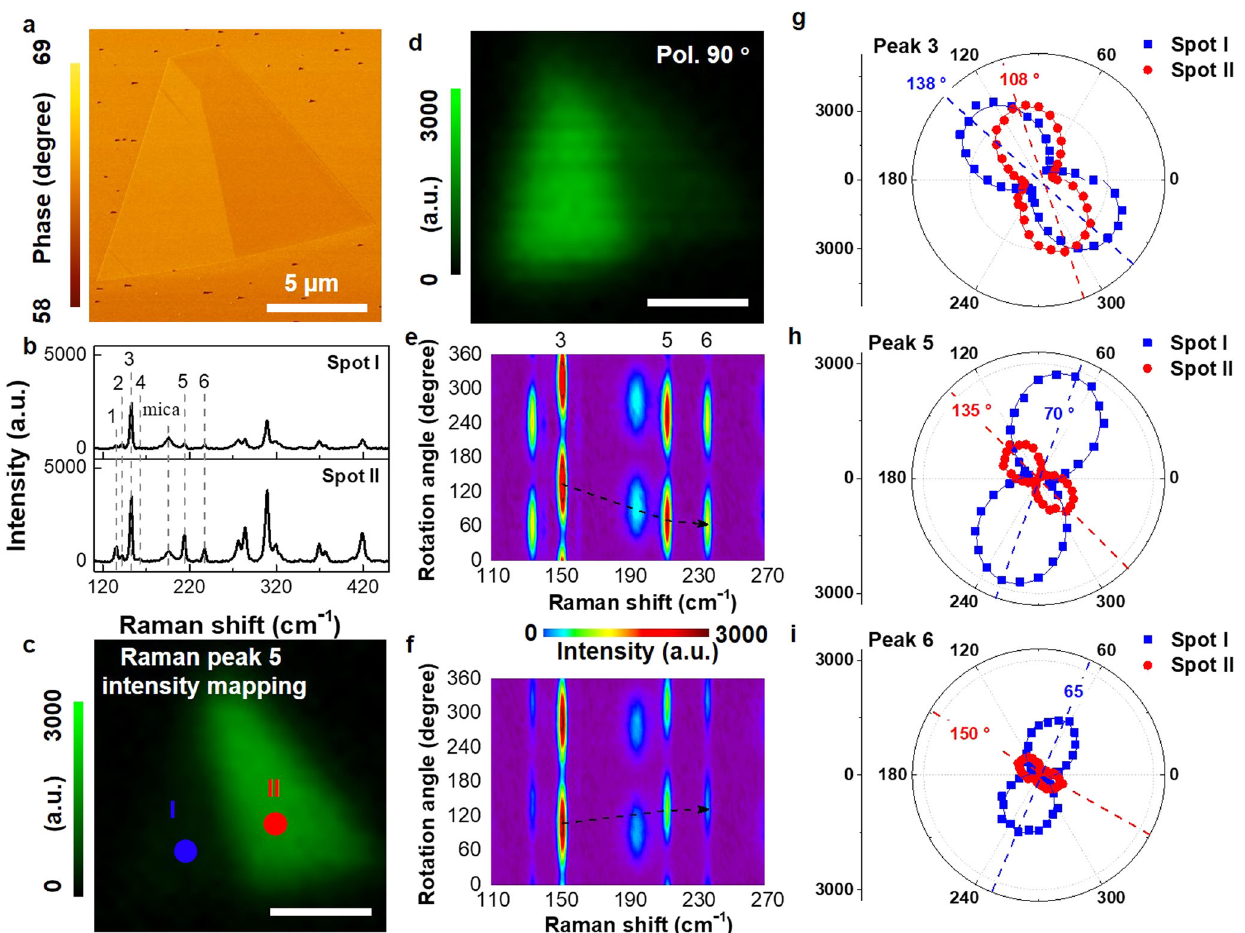
Fig. 2 The ARPR characterizations on CVD-grown 2D 1L-ReS 2 . a The DFM phase image. b The single Raman spectra (polarized 0°) of 1L-ReS 2 at different sub-domains corresponding to the blue and red spots in c . c , d The polarized 0° and polarized 90° Raman peak 5 intensity mapping, respectively. e , f Polarization-dependent Raman intensity mappings corresponding to the blue and red spots in c , respectively. g – i Angle-dependent polar plots for sub- domain I and sub-domain II at peaks 3, 5, 6 (scatter) and fi tted by Sine function (line),